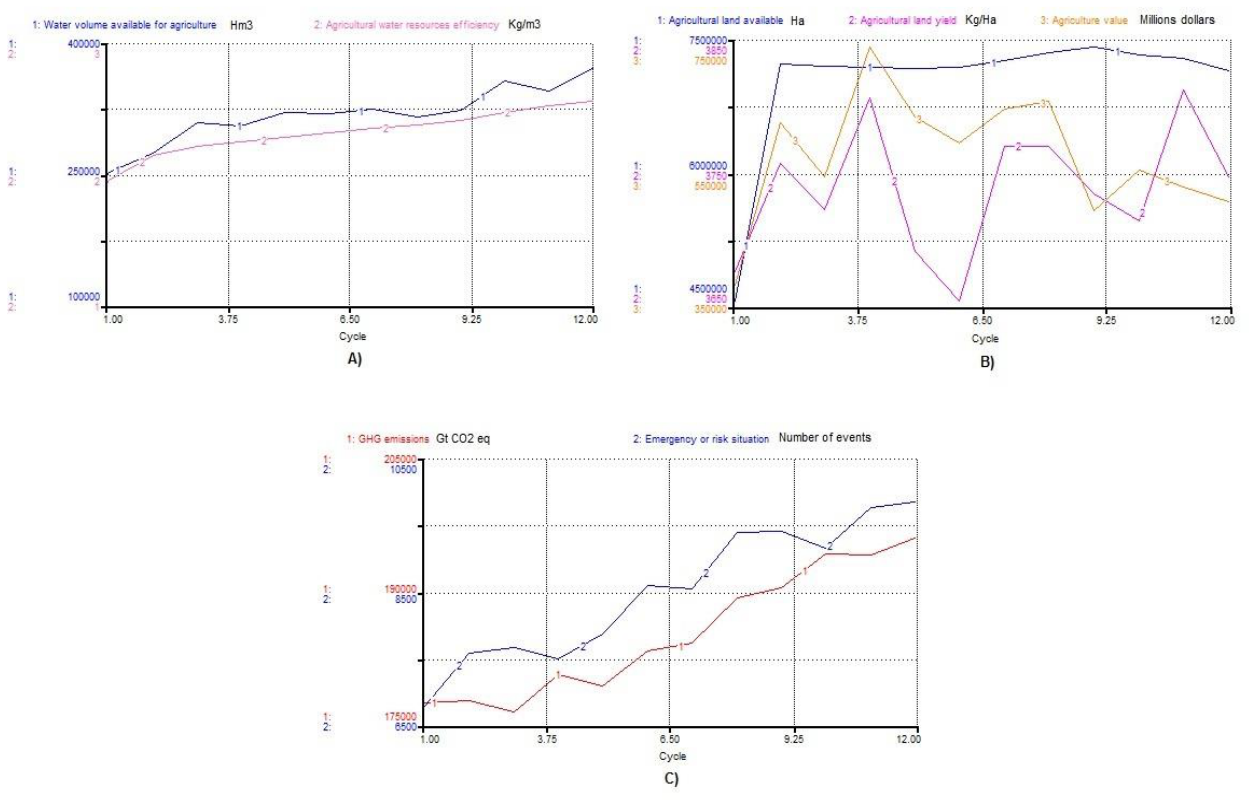
Figure 6. Projection of variables.